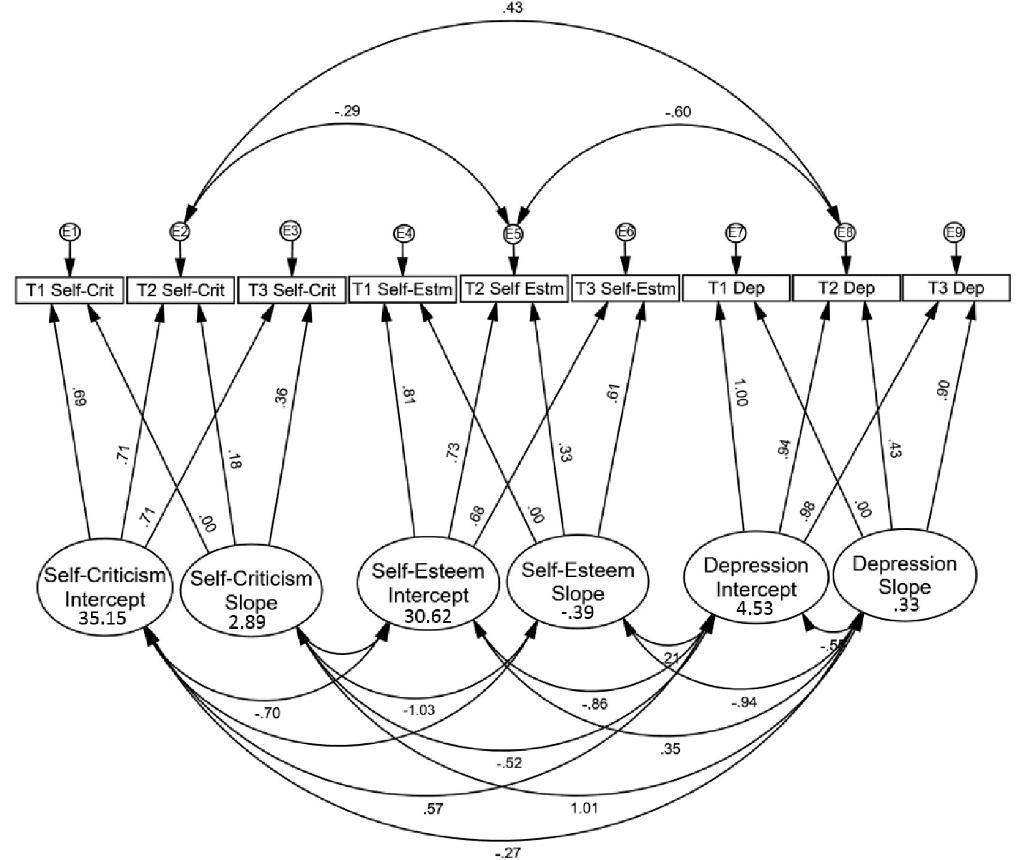
Fig 1. Growth curve model. Standardised estimates are displayed. All statistics displayed are significant at p < .05. Estimates for the latent variables appear inside the ovals. Estimates for covariances appear above or below curved, double-headed arrows. T1 = Time 1; T2 = Time 2; T3 = Time 3; Self-Crit = Self-Criticism; Self-Estm = Self-Esteem; Dep = Depressive symptoms; E = residual.